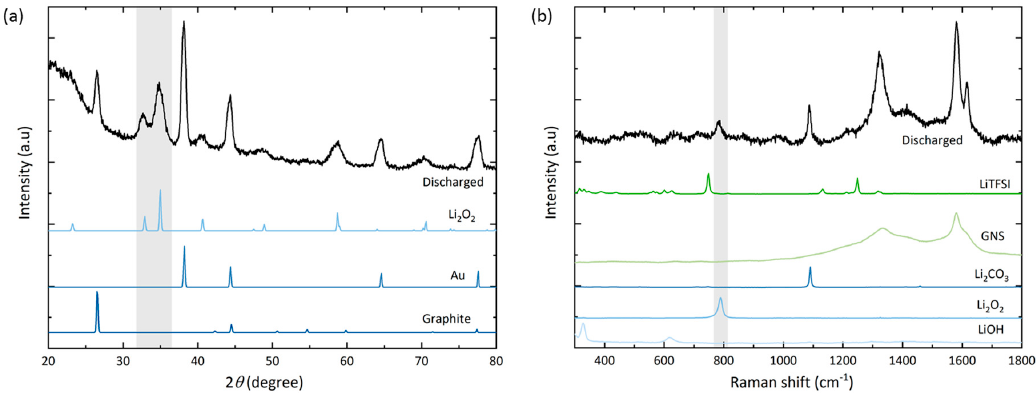
Figure 7. ( a ) XRD diffractogram and ( b ) Raman spectrum of the discharged (bottom) electrode. The highlighted grey area marks the Raman band and reflexes of Li 2 O 2 , respectively. The highlighted grey area marks the Raman band and reflexes of Li